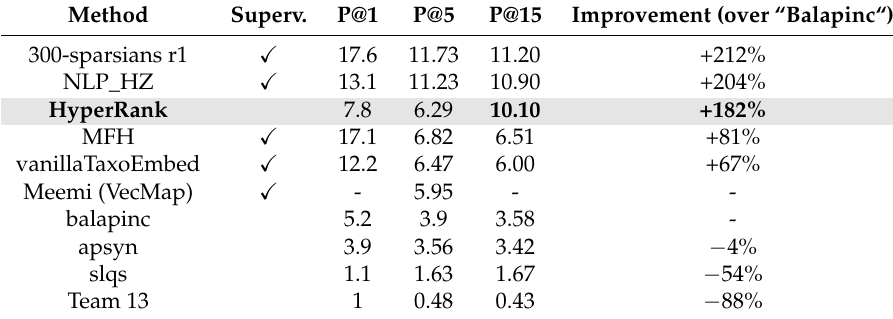
Table 5. Results of evaluation on 1B corpus.